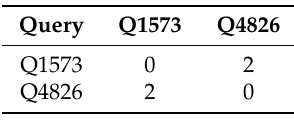
Table 7. QDM (final results).